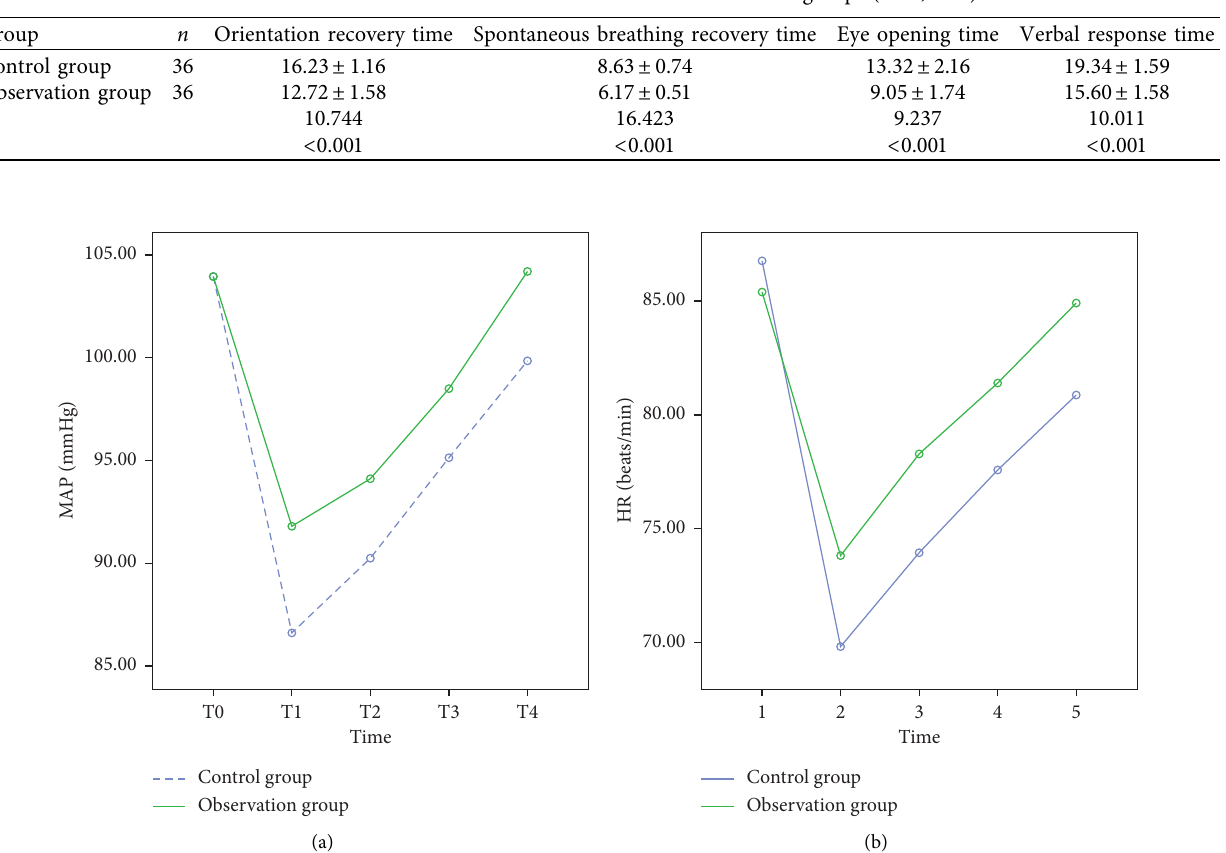
Figure 2: Comparison of perioperative hemodynamic indexes between the two groups (Note. (a) Comparison of perioperative MAP levels between the observation group and the control group; (b) comparison of HR levels between the observation group and the control group in the perioperative period). Table 2: Comparison of perioperative hemodynamic indexes between the two groups ( x ± s ).